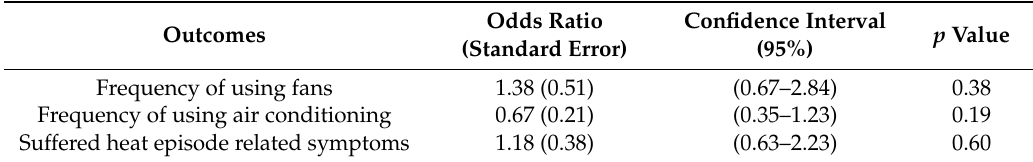
Table 5. Estimating the effects of weather warnings using ordinal